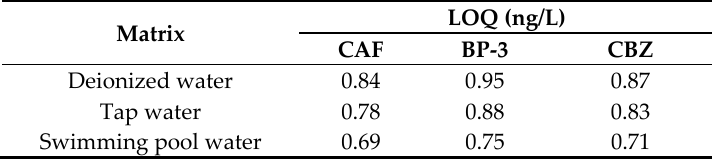
Table 7. Limits of Quantification obtained in the most optimal Solid Phase Extraction methodology (Methanol + Acetonitrile and ENVI-18) for different